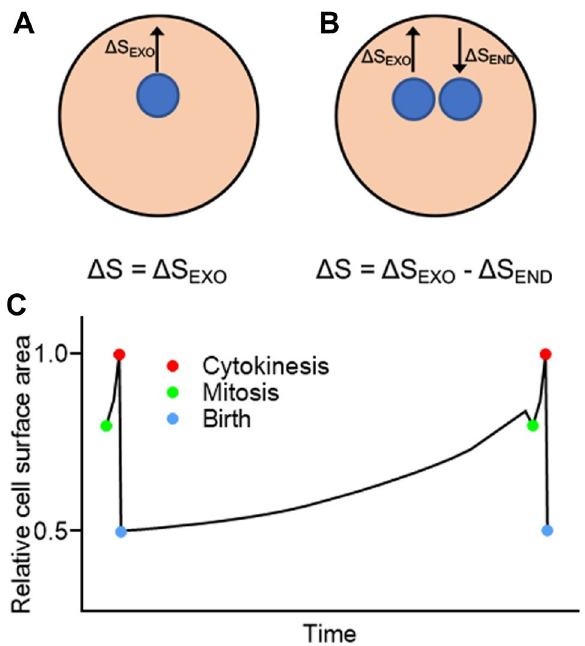
Figure 4. Dynamic adder model. ( A ) A previous adder model considered only the added surface area without taking into account the turnover of cell membrane. Here, ΔS is the total added surface area, and ΔS EXO is the added surface area due to exocytosis. ( B ) Since the cell membrane rapidly turns over, the total added surface area (ΔS) should be determined by subtracting the amount of membrane uptake by endocytosis (ΔS END ) from that of membrane supply by exocytosis (ΔS EXO ). ( C ) A summary of the dynamics of the total cell surface area in a whole cell cycle of Dictyostelium